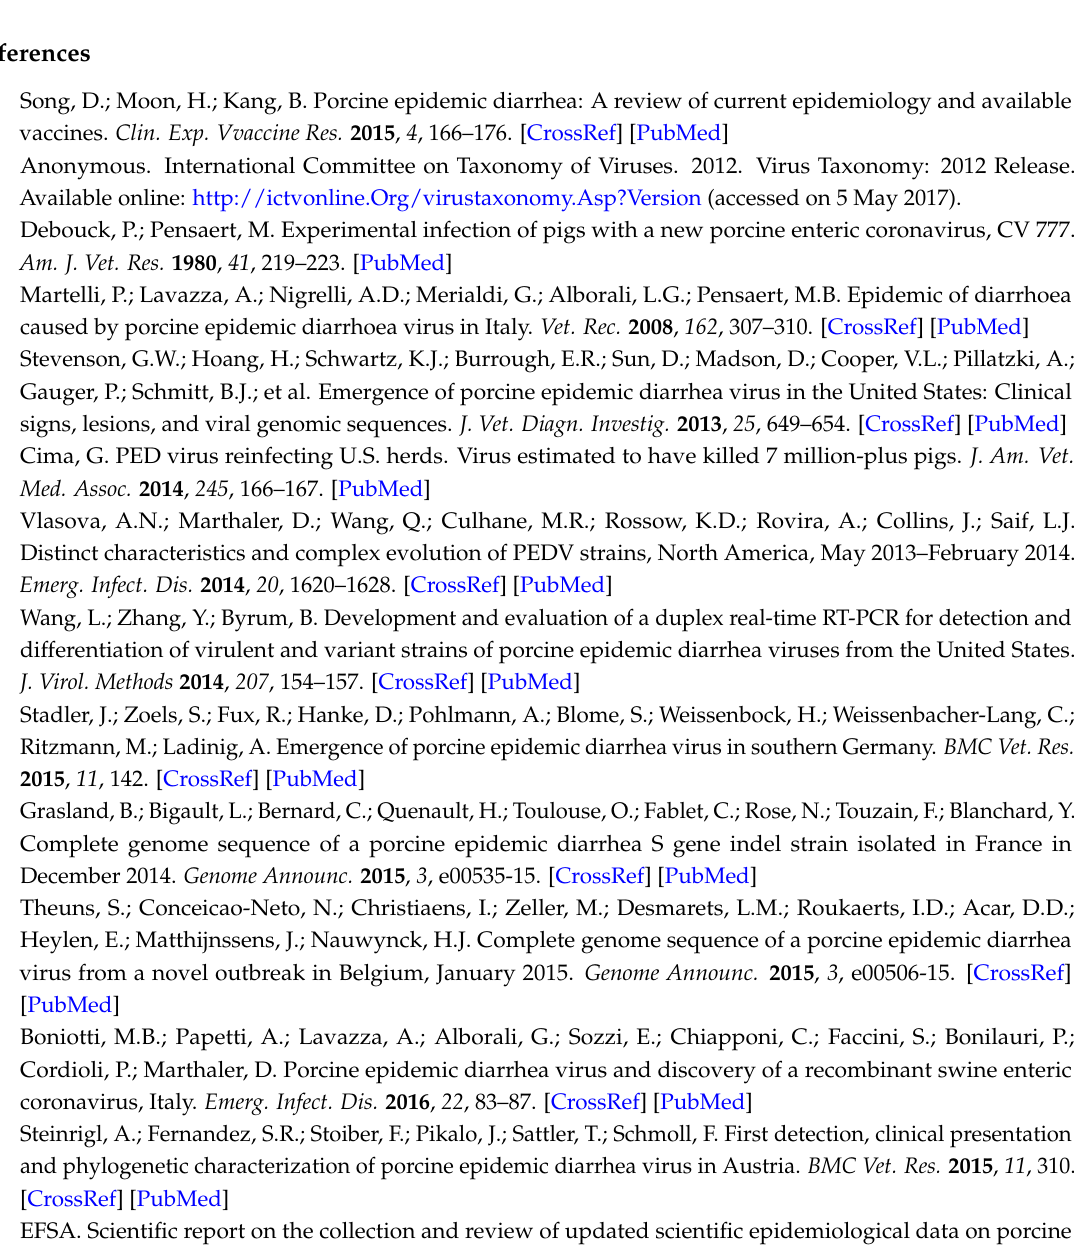
Table S1: Overview of the sequences used as references for phylogenetic analyses, Table S2: Nucleotides minor variants of sequenced PEDV samples, Table S3: Overview of metagenome analysis of selected PEDV